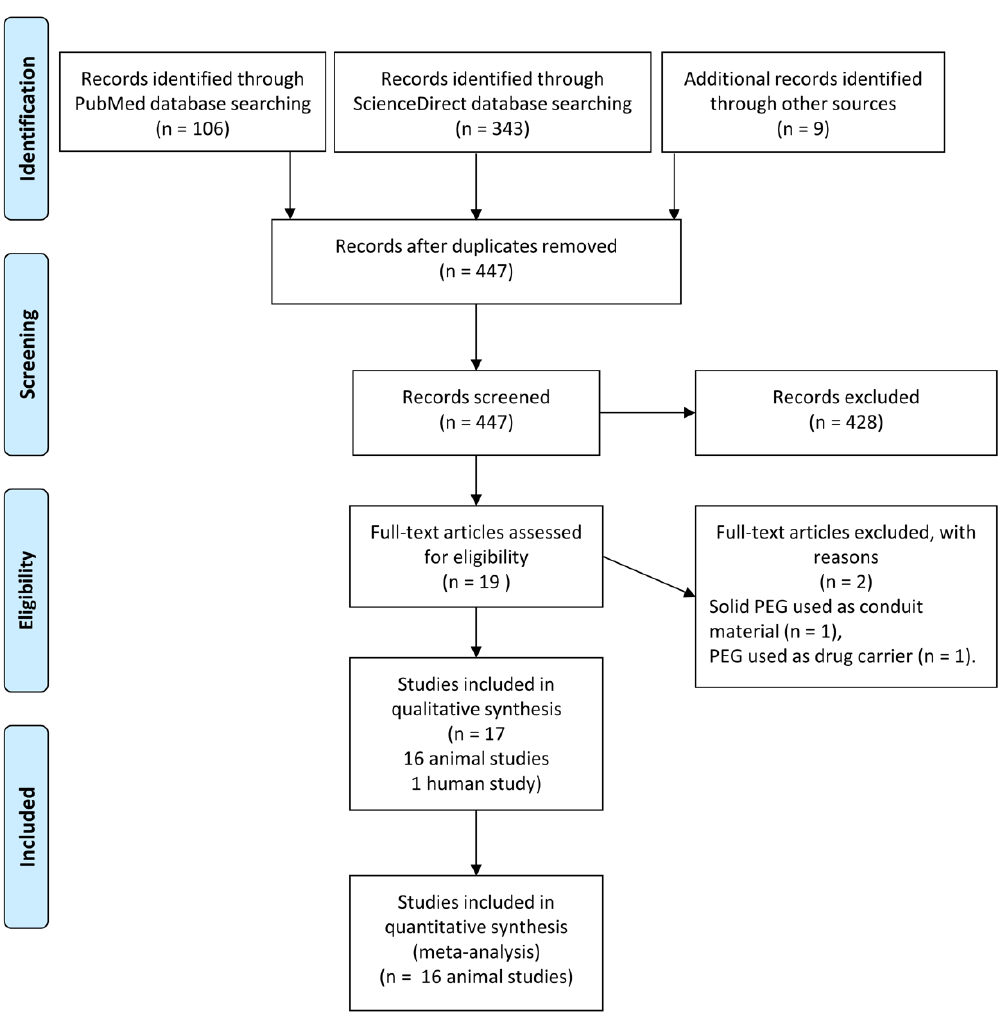
Figure 2. PRISMA flow diagram of the literature search for this systematic review.